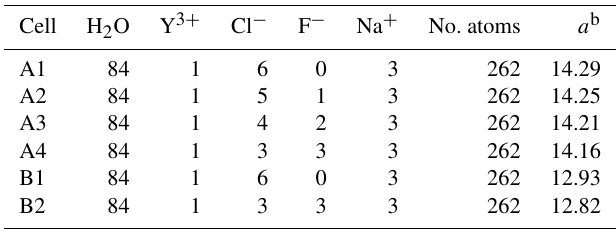
Table 1. Number of atoms in the different simulation cells together with the size of the simulation cell. A and B refer to the system density of 1072 (1.3GPa) and 1447kgm − 3 (4.5GPa) a .